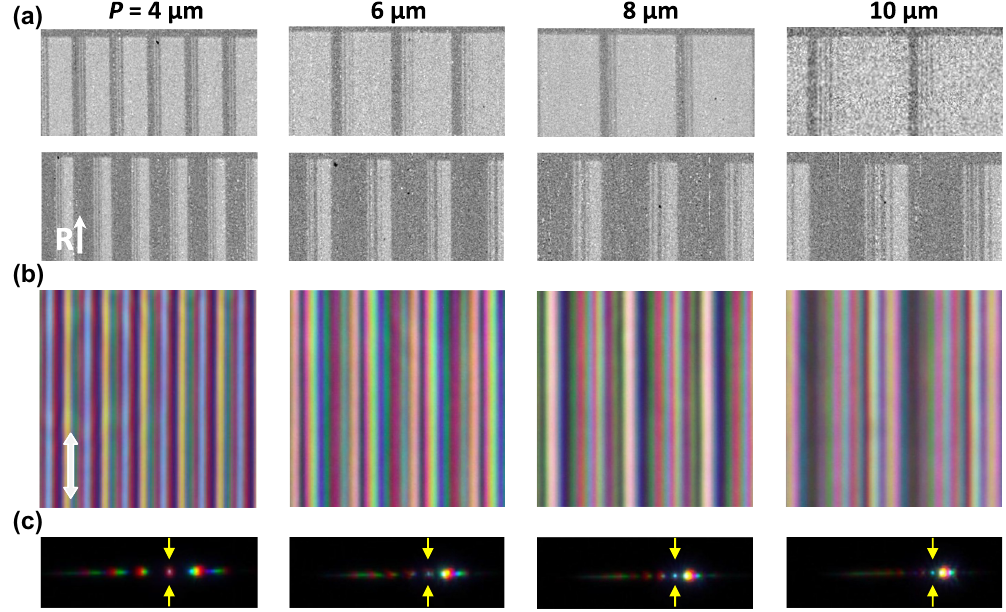
Figure 3: Experimental double-sided LC-metasurfaces self-assembling between FIB-patterned substrates. (a) SEM-images of fragments of pairs of substrates covered with polymer alignment layers rubbed in the direction of R-arrow and patterned by FIB with superperiodic stripes according to the optimized designs with the periods P indicated on the top. (b) POM-images in the light polarized along the stripes of LC metasurfaces self-assembled between the corresponding patterned substrates. (c) BFP-images of the LC metasurfaces with the spots of forward transmitted light indicated by yellow